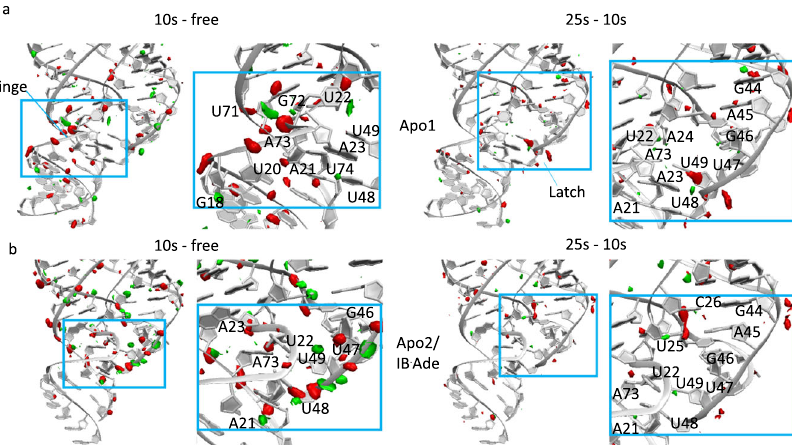
Fig. 4 Difference electron density re fl ecting early stages of AUC – TUC1 transition. F o − F o difference electron density maps, displayed for apo1 ( a ) and apo2 ( b ), generated using the ligand-free model (PDB: 5E54) and the observed structure factor differences between data sets. Left: AUC-10 s — AUC free; right: AUC-25 s – AUC-10 s. Positive and negative density are shown in green and red, respectively, contoured at 3